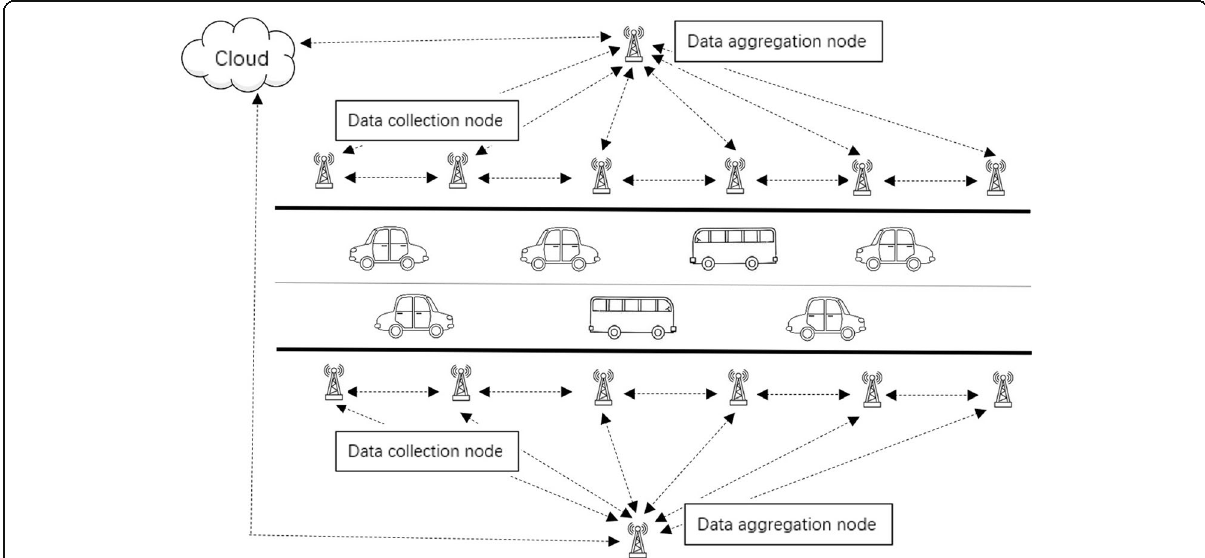
Fig. 1 Traffic flow collecting system architecture based WSN. The data collection node uses RFM69HCW wireless module and magnetometer sensor FXOS8700CQ to build the hardware part. The magnetometer sensor identifies the vehicle flow and speed based on the vehicle's disturbance to the earth's magnetic field, and then the wireless module aggregates the data into the aggregation node. Finally, the aggregation node data is transmitted to the remote cloud server via the mobile